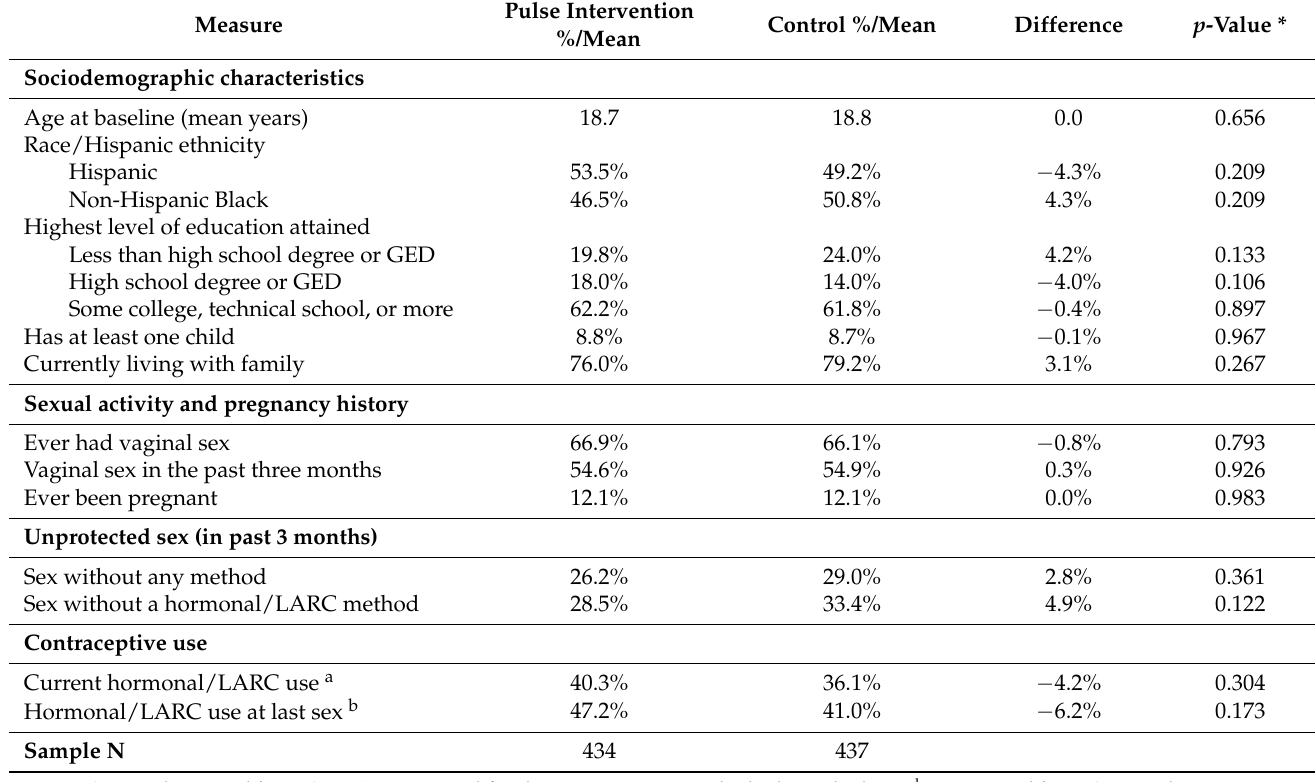
Table 1. Baseline characteristics of replication study participants who completed the six-week follow-up survey by intervention/control status ( n =